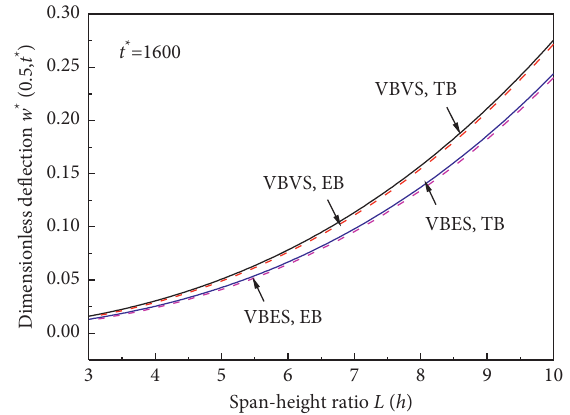
Figure 9: Response of dimensionless midspan deflection w ∗ (0.5, t ∗ ) versus slenderness ratio L / h of the viscoelastic Timoshenko and Euler cracked beams.